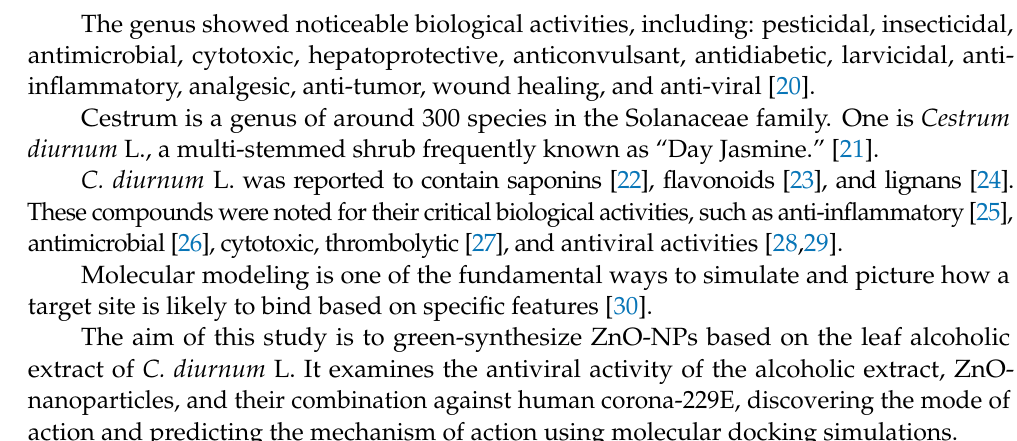
Figure 2. HPLC chromatogram of phenolic compounds of C. diurnum leaves extract. 2.2. HPLC Analysis of Alkaloid Constituents HPLC analysis of C. diurnum L. leaves alcoholic extract (Figures 3 and 4) indicated the presence of cotinine, nicotyrine, solanodine, nornicotine, and nicotine with concentra- tions of 10.66, 9.74, 9.65, 8.89, and 8.55 µg/g, respectively (Table 2). Solanidine was previ- ously detected in the leaves of C. purpureum [19]. Nicotine and nornicotine were detected